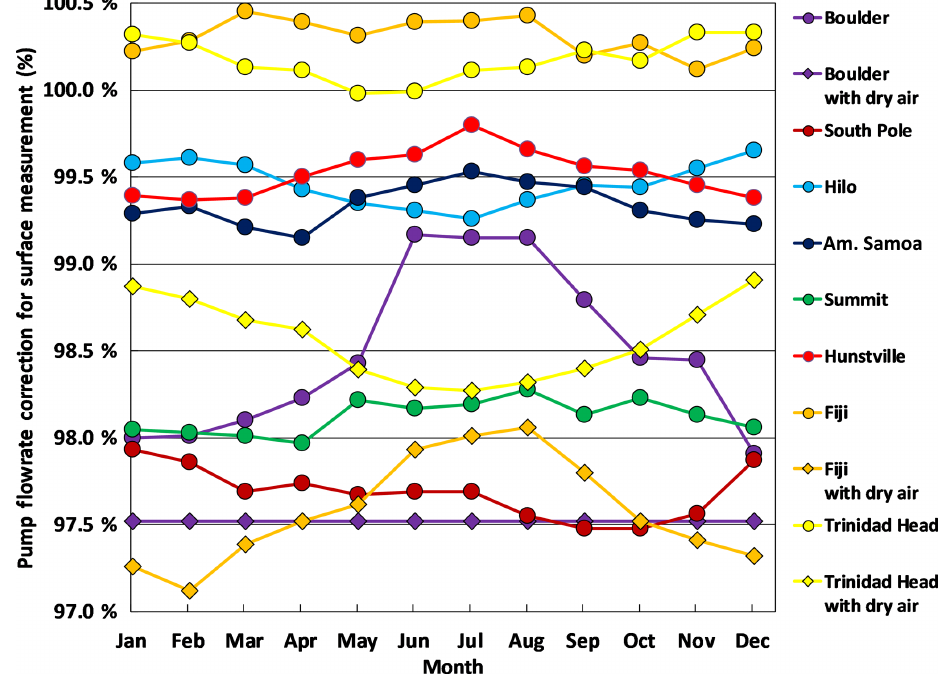
Figure 3. Monthly climatological volumetric pump flowrate corrections for surface